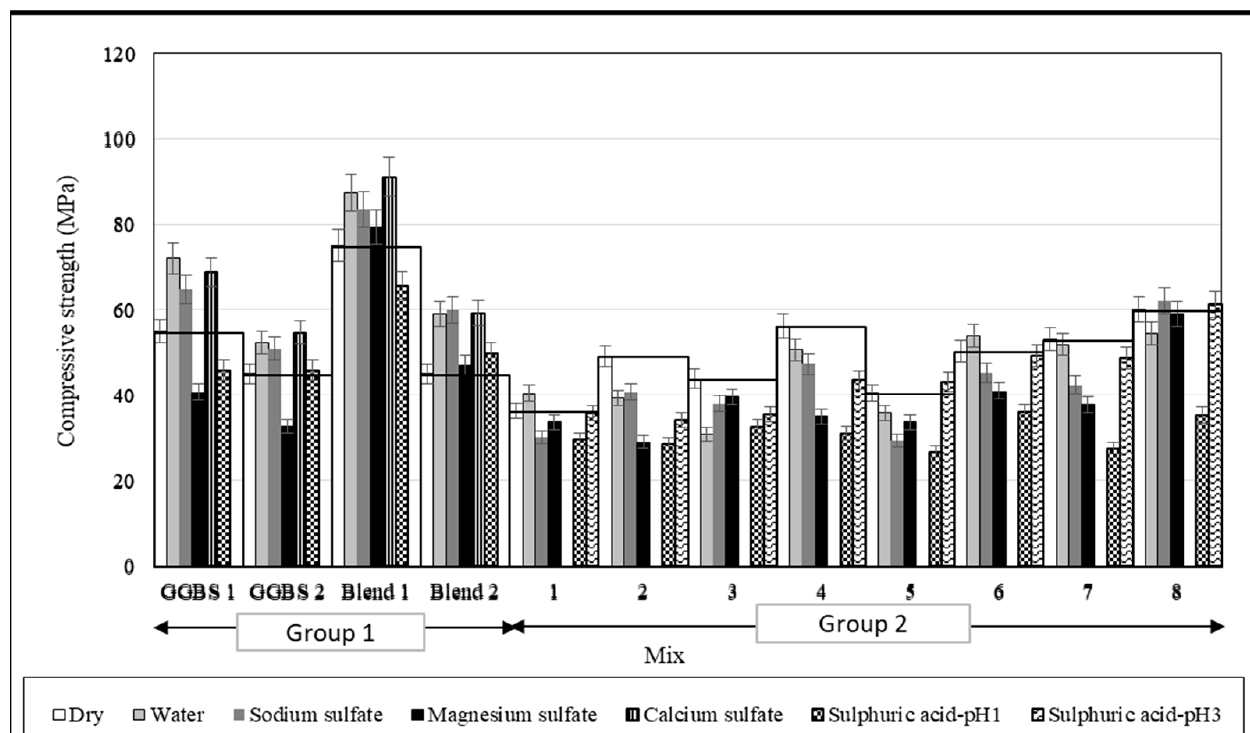
Figure 3. The compressive strength of AASC and AAS/F concrete samples kept in sealed conditions and exposed to various solutions (Water, Na 2 SO 4 , MgSO 4 , CaSO 4 , H 2 SO 4 -pH 1, and H 2 SO 4 -pH 3) at 485 days for the first group and at 820 days for the second group of mixes.